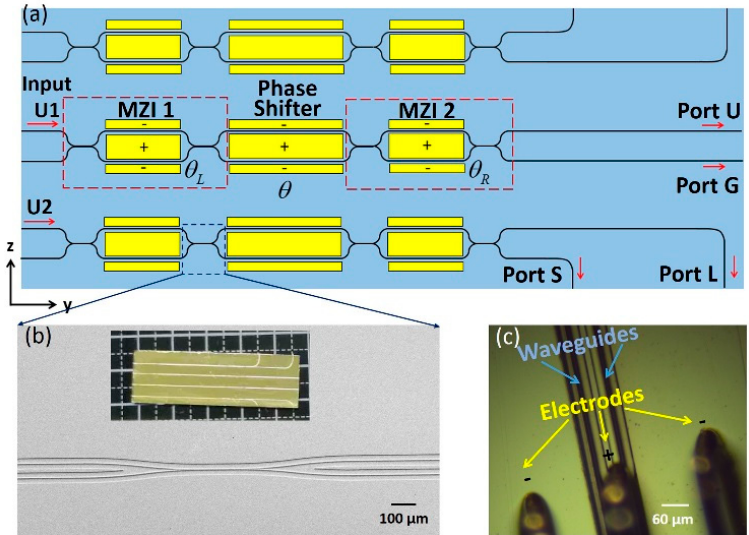
Figure 4. (a) Device layout. Here, phase differences θ L , θ , and θ R were contributed by fabrication imperfections of interferometer arms and of electro-optic (EO) modulation. (b) SEM image of directional coupler; inset: overview photograph of fabricated device consisting of three beam splitters. (c) Optical-microscope image of electrodes contacted by three pins.